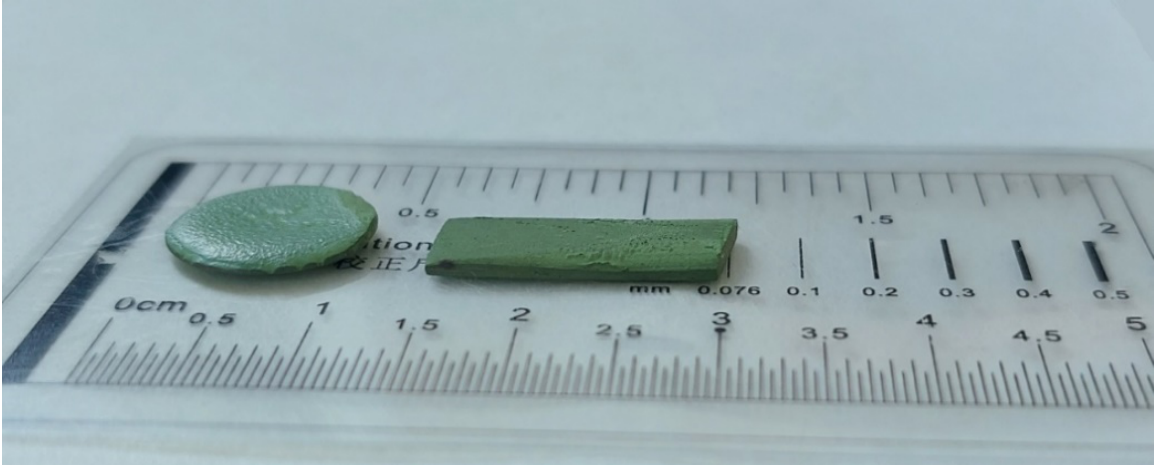
Figure 6. Printed samples of NiO/YSZ anodes of various shapes on a calibration ruler.